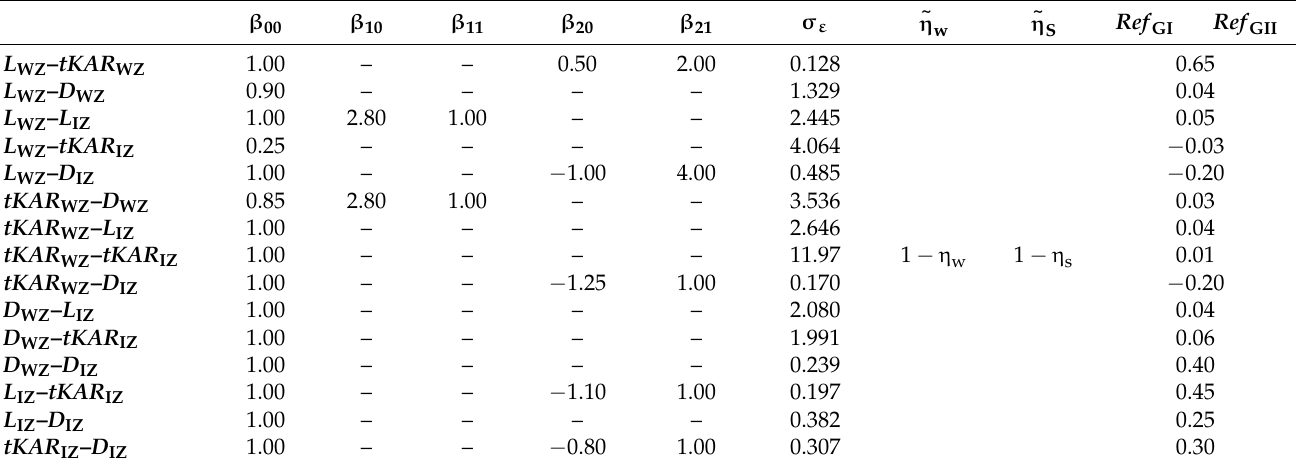
Table 4. Regression coefficients, standard deviations of the error term, and reference values of the regression models for the correlation functions and reference values of GI and